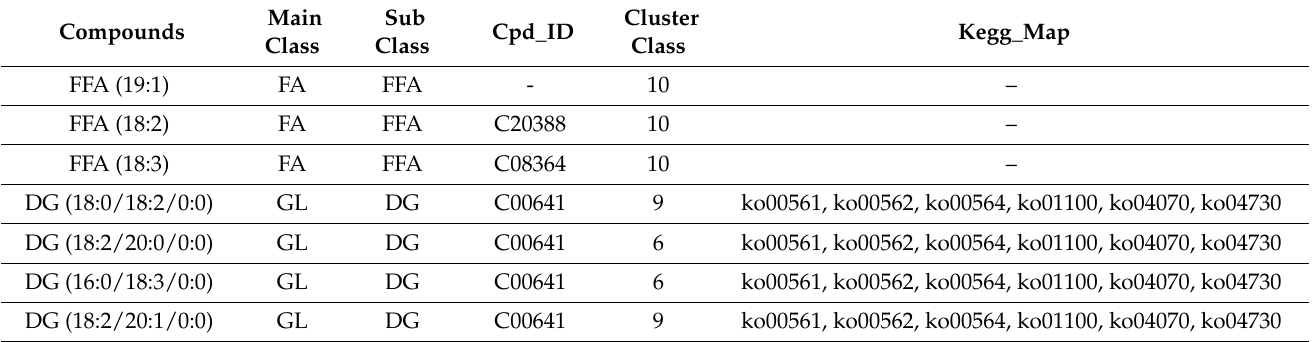
Table 5. Overview of the 33